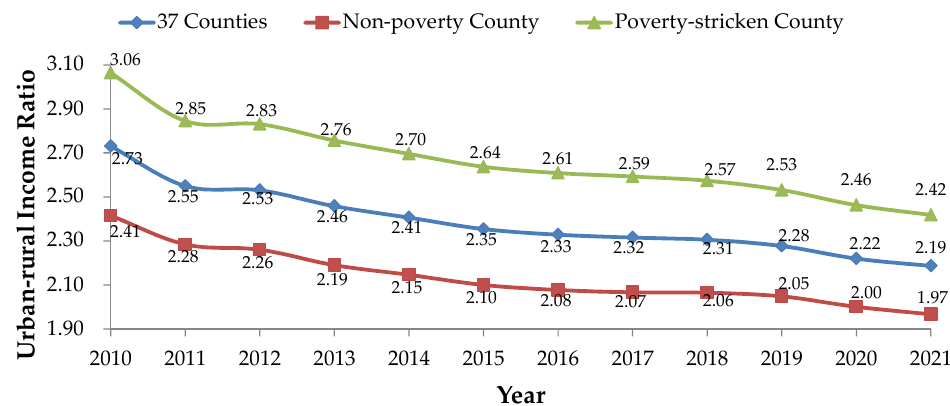
Figure 4. Change trend of the urban–rural income ratios of various counties in Chongqing.